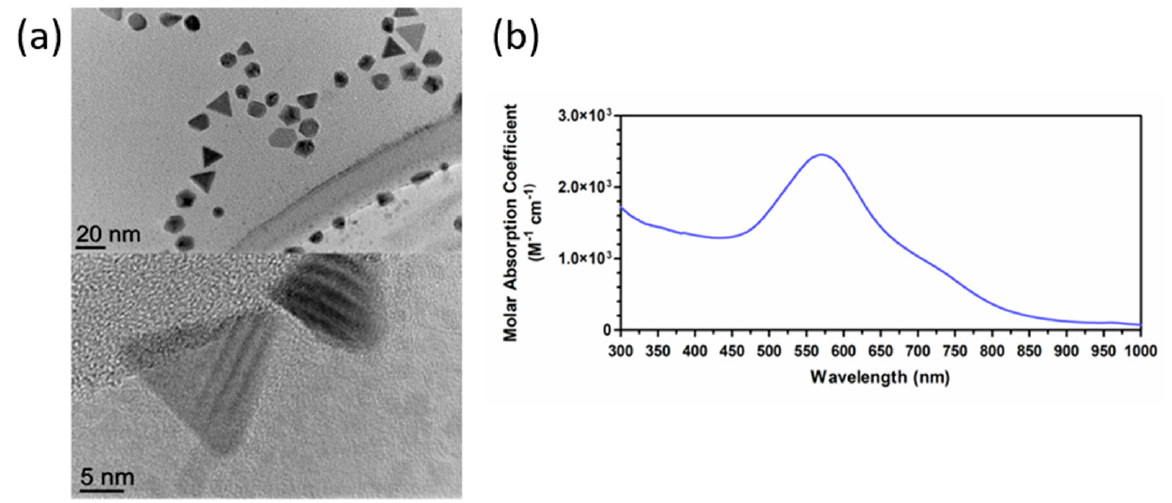
Figure 1. ( a ) Transmission electron microscopy (TEM) images of the obtained AuAgNTrs@PEG. ( b ) UV–Vis spectrum of AuAgN-Trs@PEG.